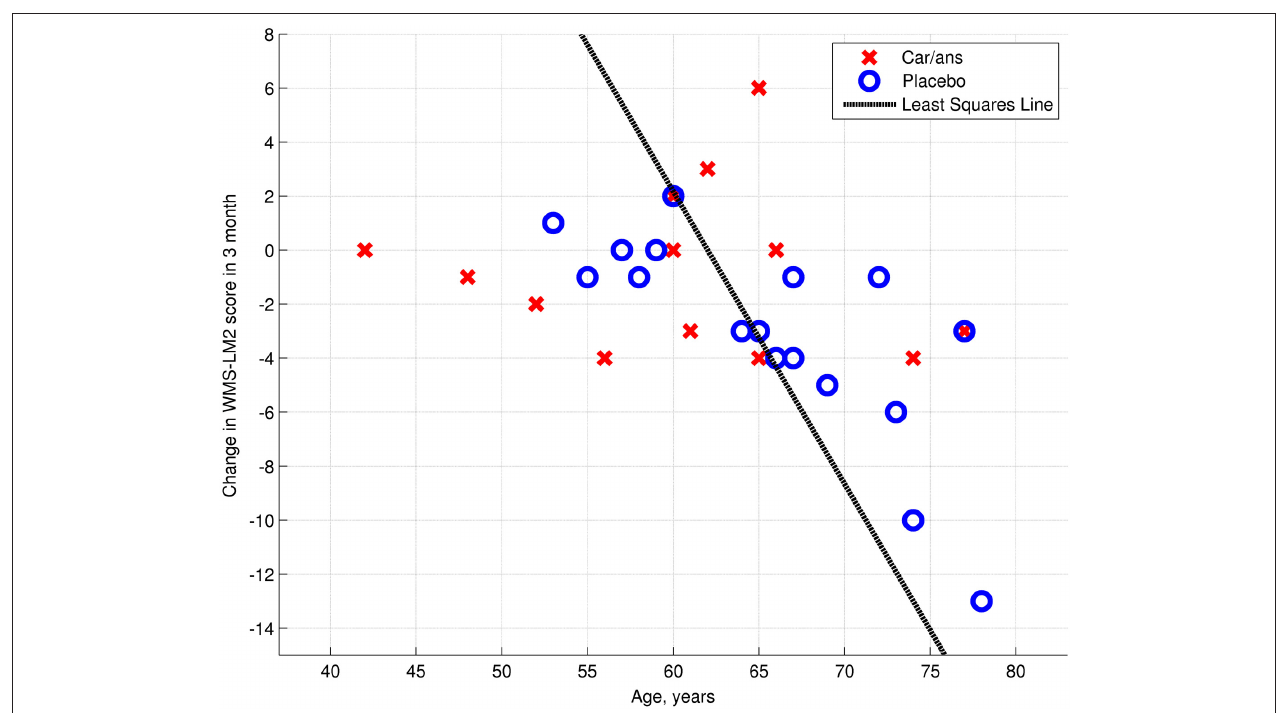
FIGURE 7 | Dependency between age and change in WMS-LM2 score (Spearman’s r = 0.493 , p = 0.023 ). Carnosine/anserine (car/ans) subjects are presented with red crosses and placebo subjects with blue